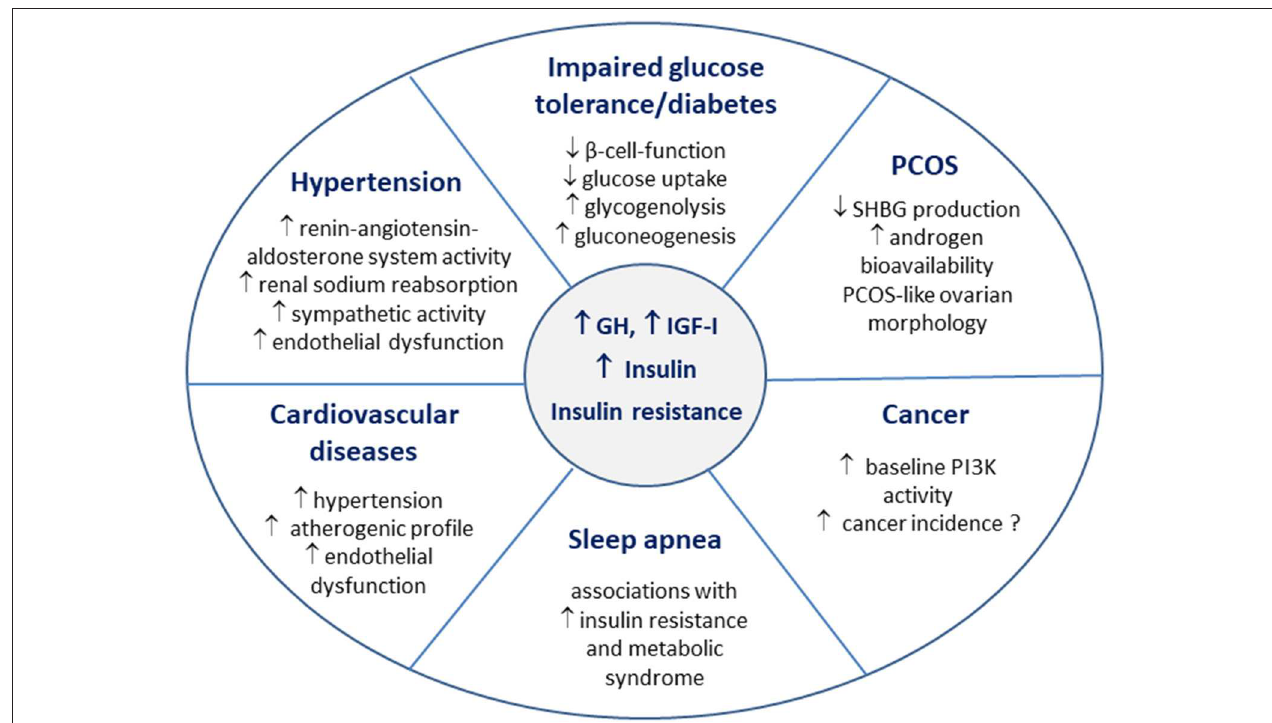
FIGURE 2 | Insulin resistance in the pathophysiology of acromegaly